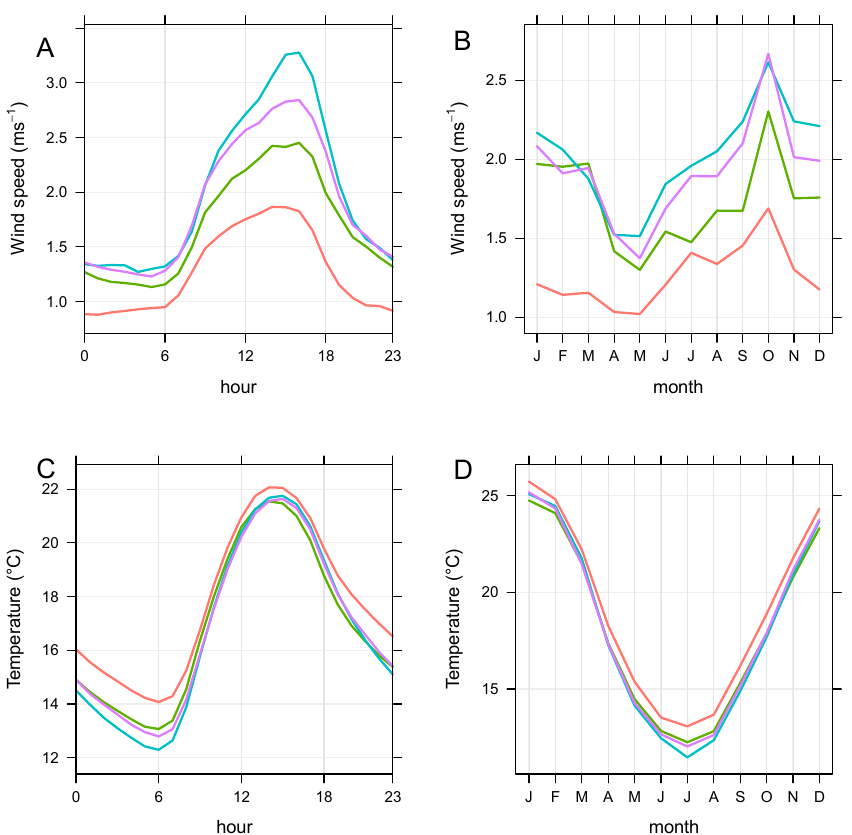
Figure 3. Diurnal and seasonal cycles of mean wind speed (( A , B ), respectively) and temperature (( C , D ), respectively) at the Auburn balcony site and three surrounding air quality monitoring stations; 95% confidence intervals in the mean are shaded.